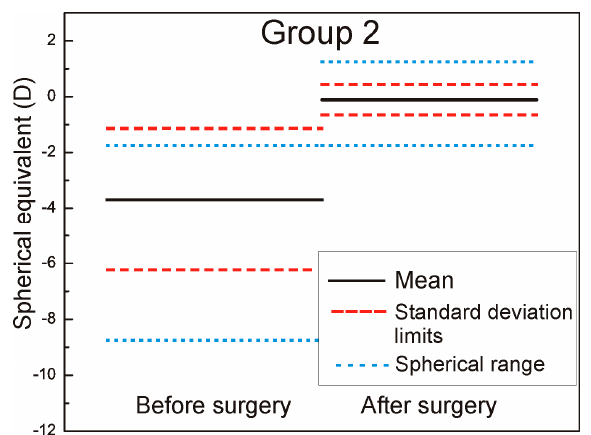
Figure 2. Refractive spherical equivalent pre- and postoperative Group 2.